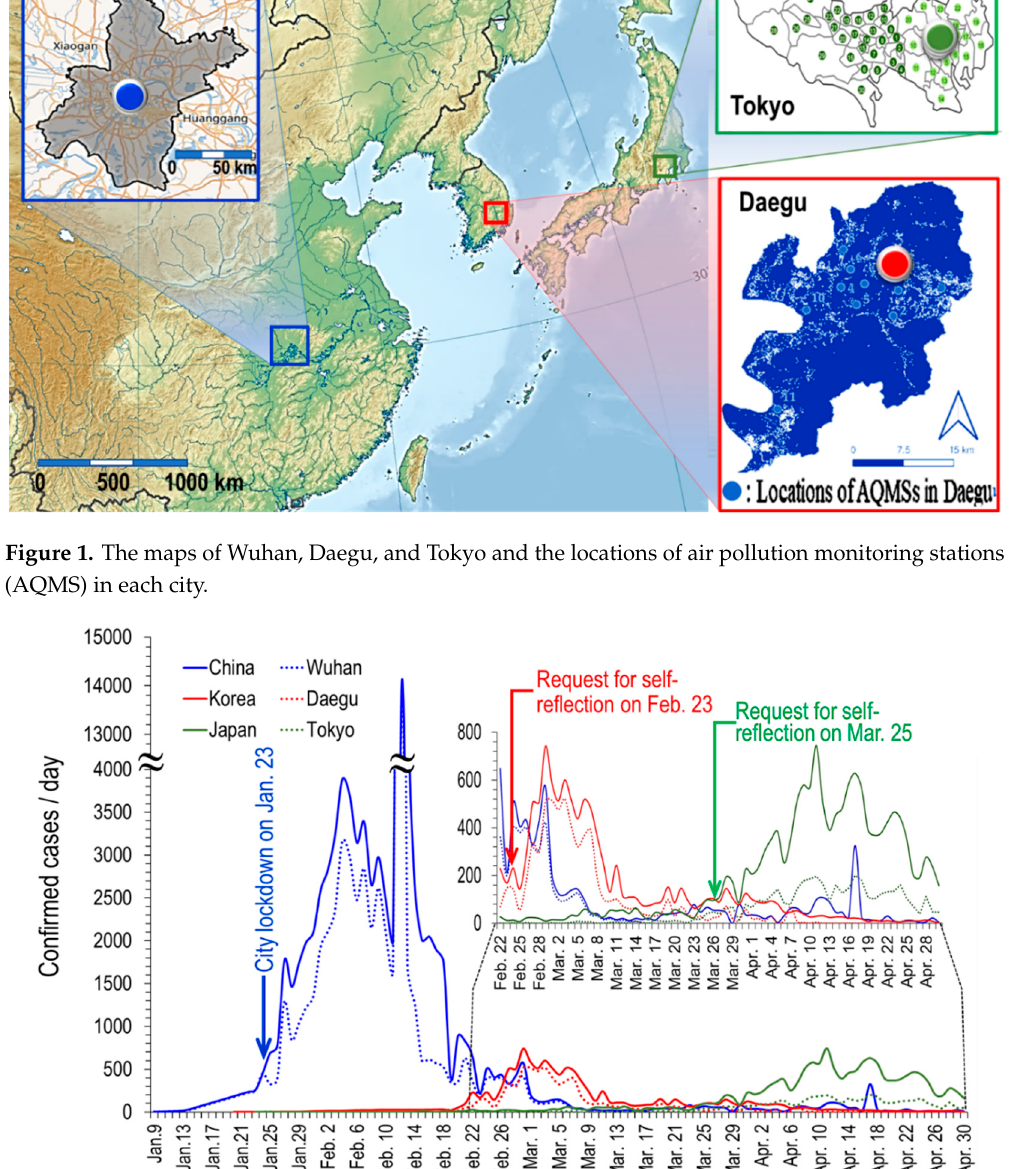
Figure 2. Timely variation of the confirmed cases of COVID-19 per day in Wuhan / China, Daegu / Korea, and Tokyo / Japan.